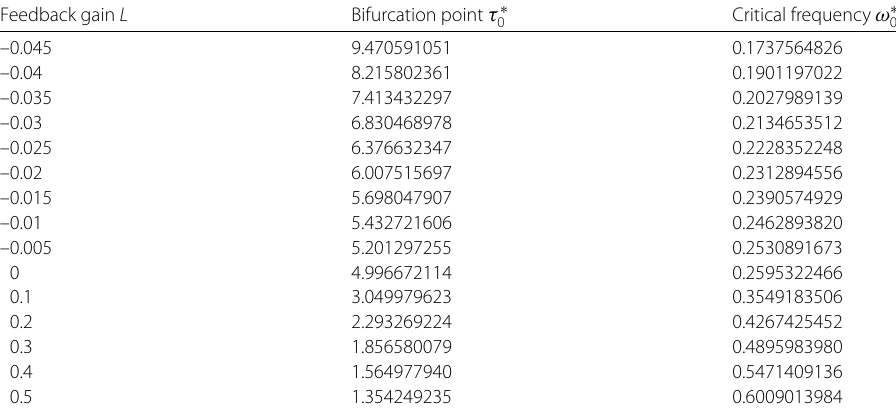
Table 1 The impact of the feedback gain L on the first bifurcation point τ ∗ for the controlled system (4.24). This table lists the values of the first bifurcation point τ ∗ corresponding to some feedback gain L , which are calculated from the linearized frequency ω ∗ 0 average system (4.26) of the controlled system (4.24) with the parameter values r = 1.2, k = 20, c = 0.9, d = 0.3, e = 0.3, m = 0.8, q = 0.98 Feedback gain L Bifurcation point τ ∗ 0 Critical frequency ω ∗